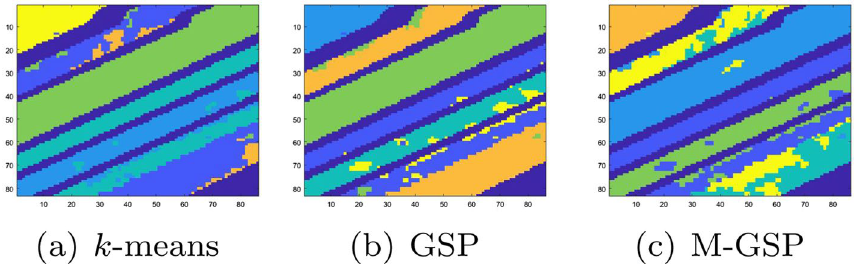
Fig. 9 Segmented results of Salinas A